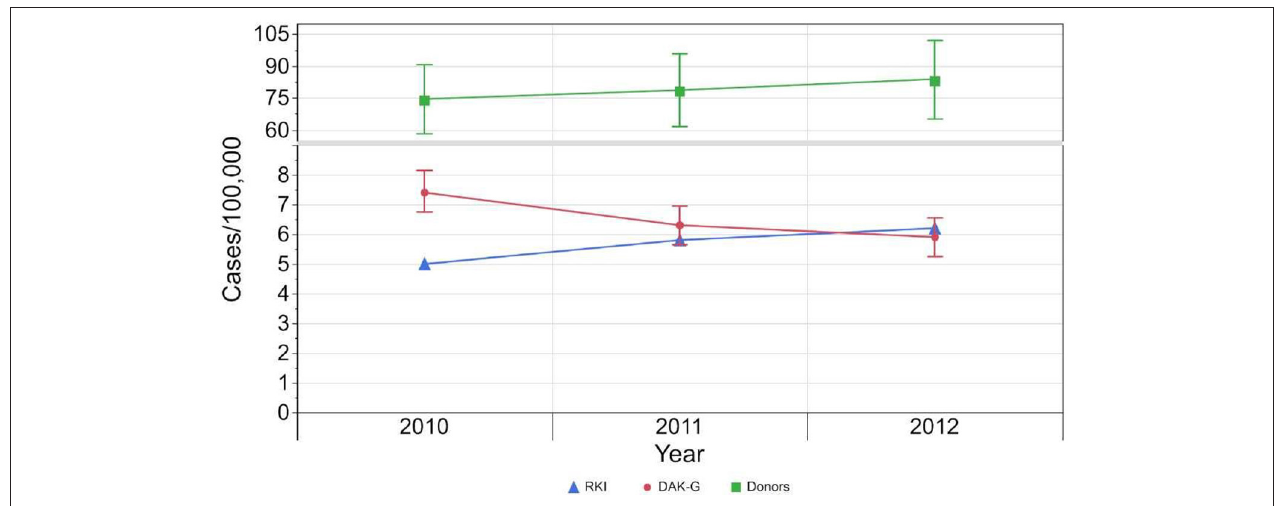
FIGURE 4 | Development of incident cases reported to RKI (blue), standardized incident cases based on health insurance data set (red) and standardized seroprevalence (green) per 100,000 standardized population from 2010 to 2012. The 95 %-confidence intervals of the estimated results per 100,000 standardized person-years are indicated by the whiskers.